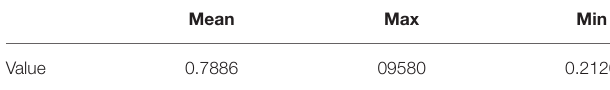
TABLE 3 | Descriptive statistics of the dynamic correlation.